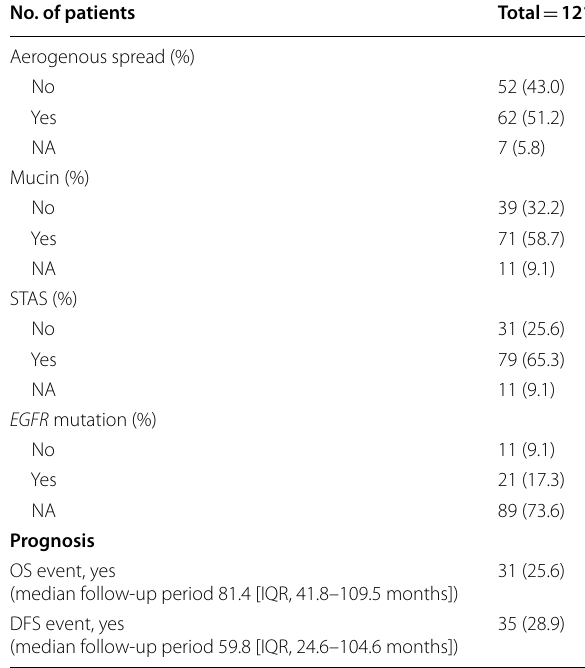
12.6 cm in diameter. The median tumor size of the 91